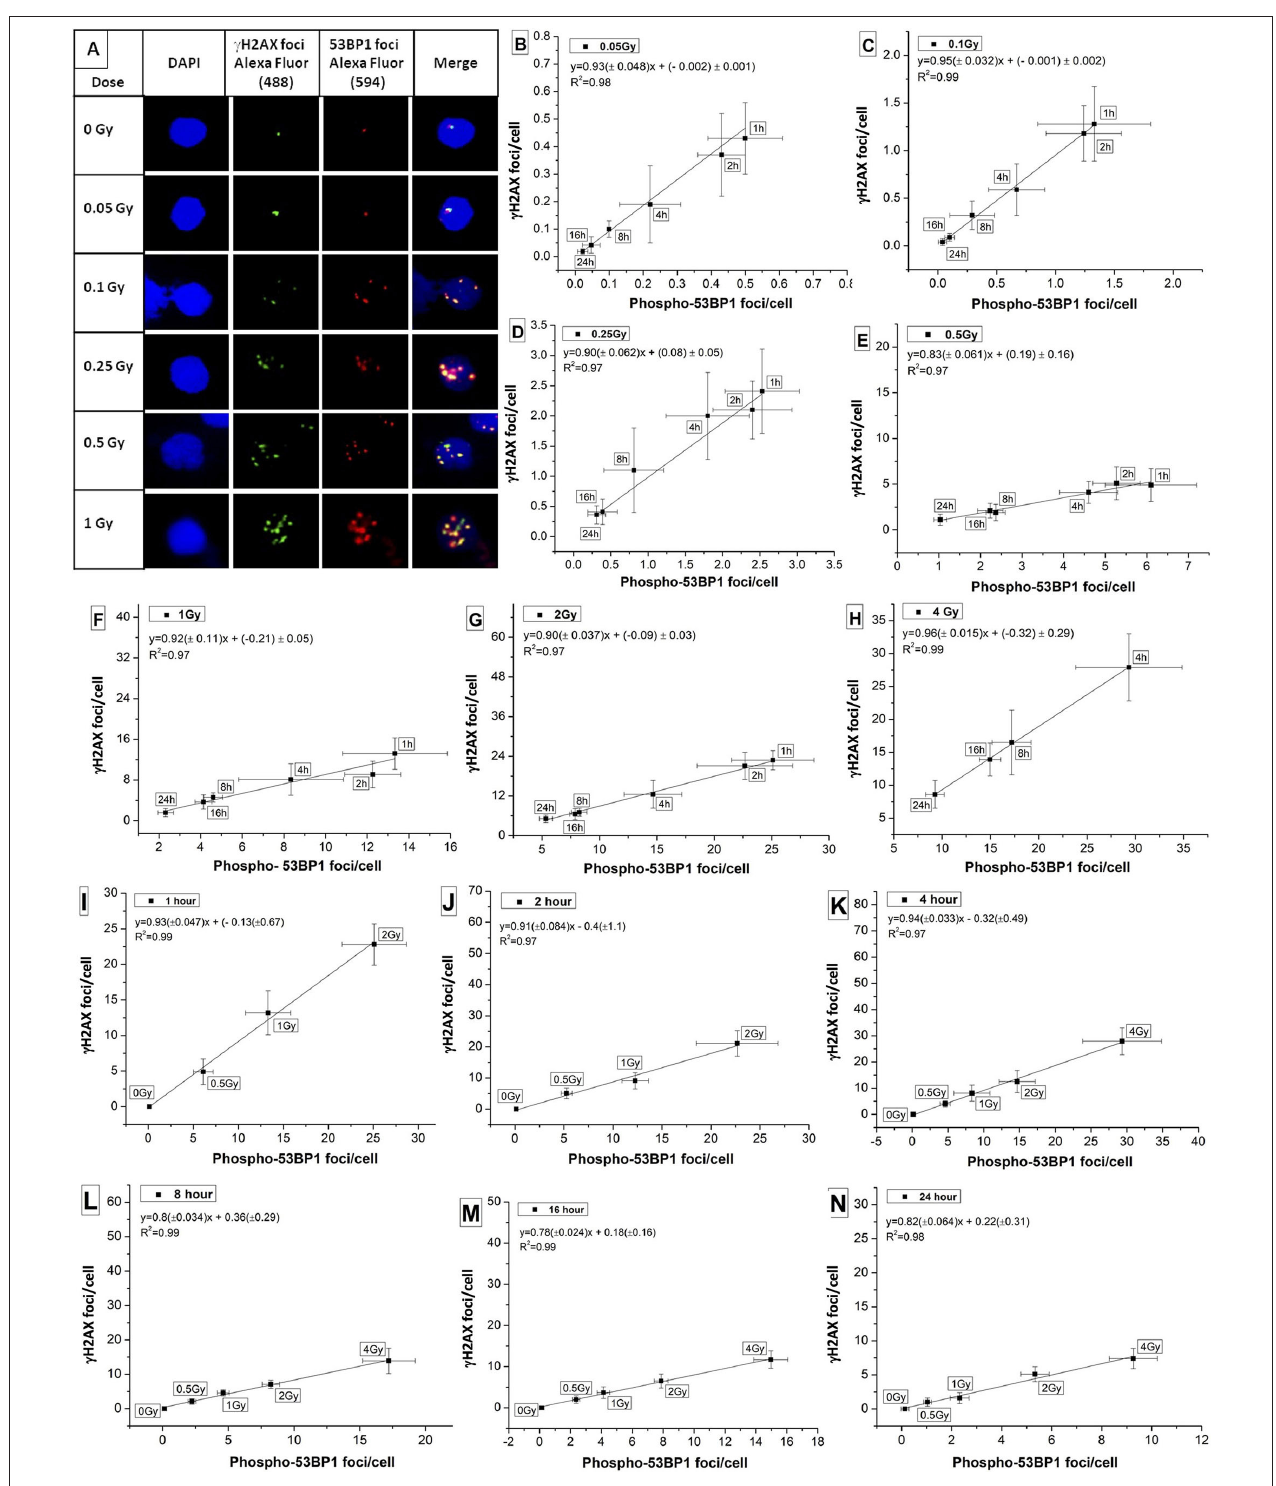
FIGURE 4 | (A) Colocalization of phospho-53BP1 and γ H2AX foci in the nucleus of human lymphocyte exposed with various doses (at 1h incubation post irradiation). Correlations established between dose-response curves generated for phospho-53BP1 foci and γ H2AX foci (data not shown) at dose points (B) 0.05Gy (C) 0.1Gy (D) 0.25Gy (E) 0.5Gy (F) 1Gy (G) 2Gy (H) 4Gy with varying incubation time points (1–24h) after irradiation. Correlations were established between dose-response curves generated for phospho-53BP1 foci and γ H2AX foci, at (I) 1h (J) 2h (K) 4h (L) 8h (M) 16h and (N) 24h of incubation after irradiation with various doses